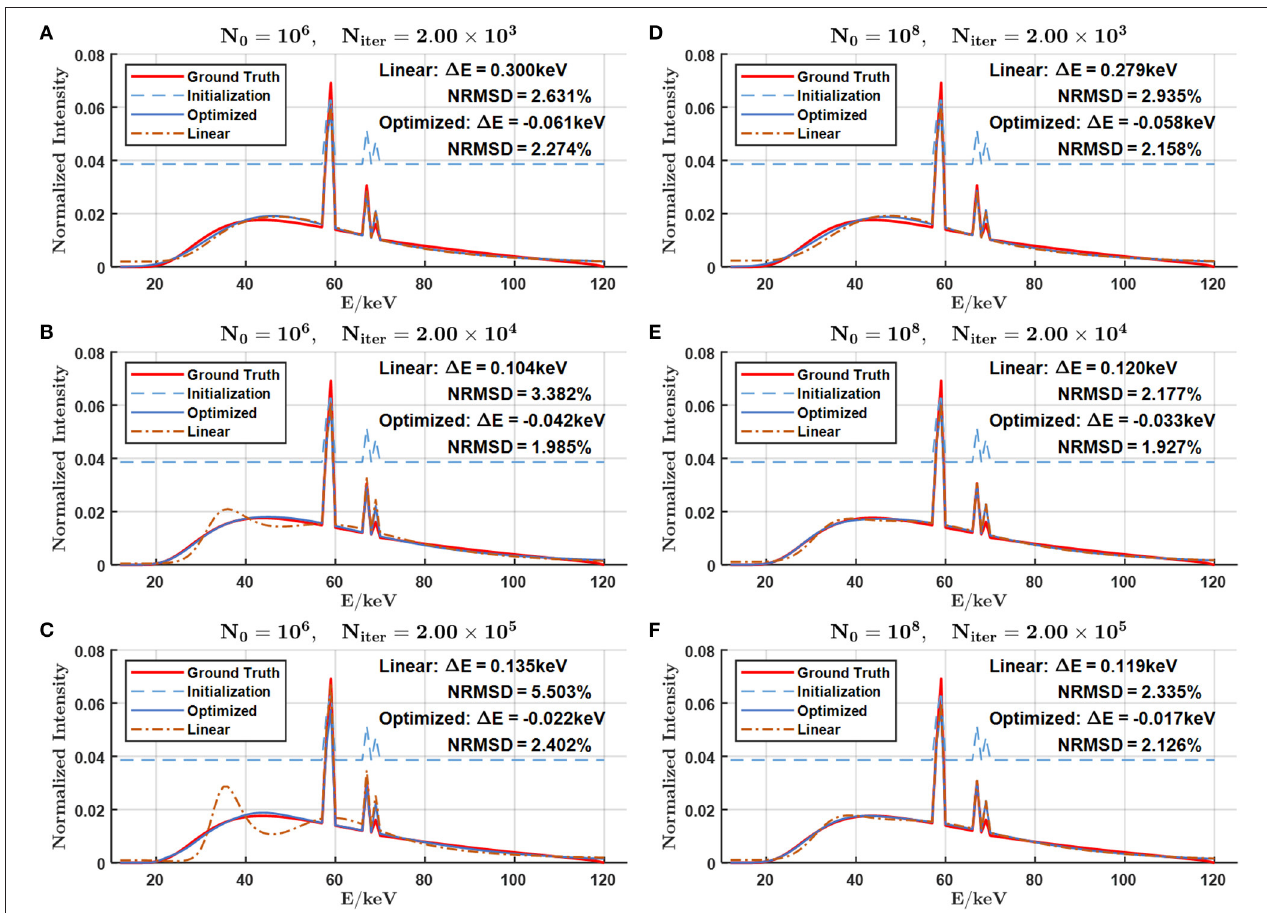
FIGURE 8 | Spectrum estimations from M 15 optimally arranged thicknesses against M 15 best linearly arranged thicknesses through N iter iterations under two = = noise levels characterized by N 0 , (A) N 0 10 6 , N iter 2.00 10 3 , (B) N 0 10 6 , N iter 2.00 10 4 , (C) N 0 10 6 , N iter 2.00 10 5 , (D) N 0 10 8 , = = × = = × = = × = N iter 2.00 10 3 , (E) N 0 10 8 , N iter 2.00 10 4 , and (F) N 0 10 8 , N iter 2.00 10 5 . The initialization is shifted upward by 0.03 for better visibility. The mean = × = = × = = × energy difference and the NRMSD of the estimated spectra against the ground truth are